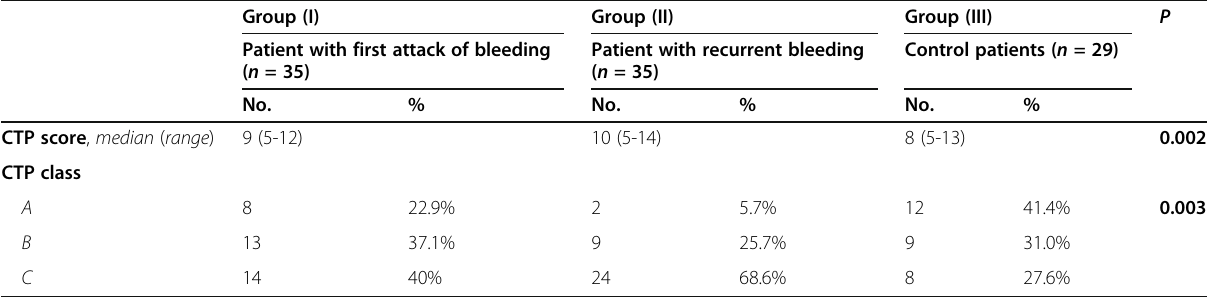
Table 7 Severity of liver disease in studied population ( n = 99) Group (I) Group (II) Patient with first attack of bleeding ( n = 35)